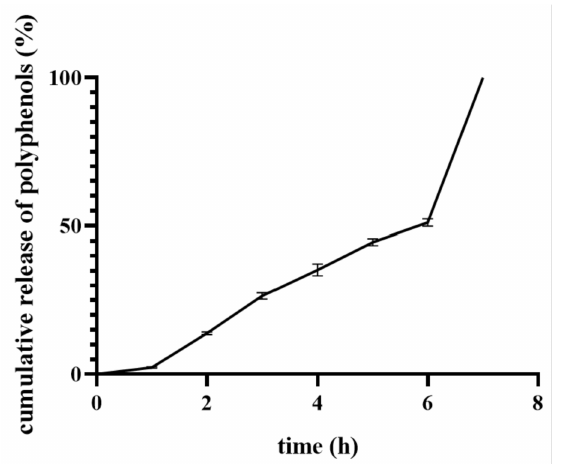
Figure 8. In vitro release assay of cross-linked lyophilized emulsion with incorporated PLA micro- spheres containing Calendula officinalis flower extract (ALG/GEL/G(1%)/L(3.4%) +